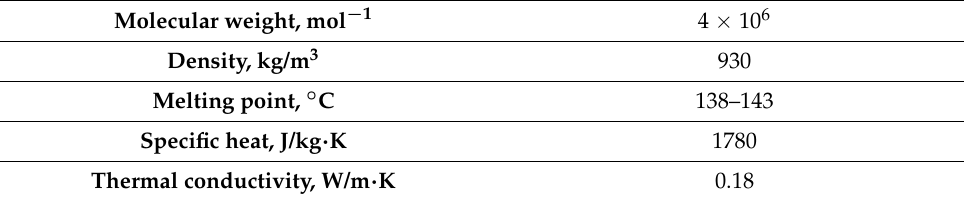
Table 1. Properties of UHMWPE powder.